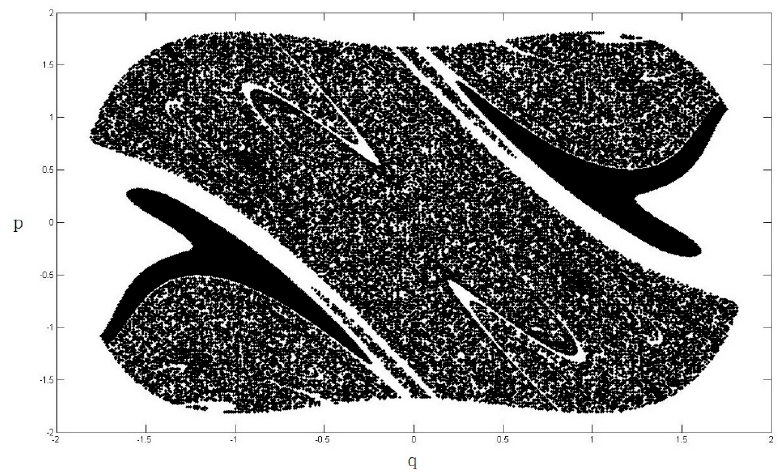
Figure 6. Safe basin of the system when e = 0.6.